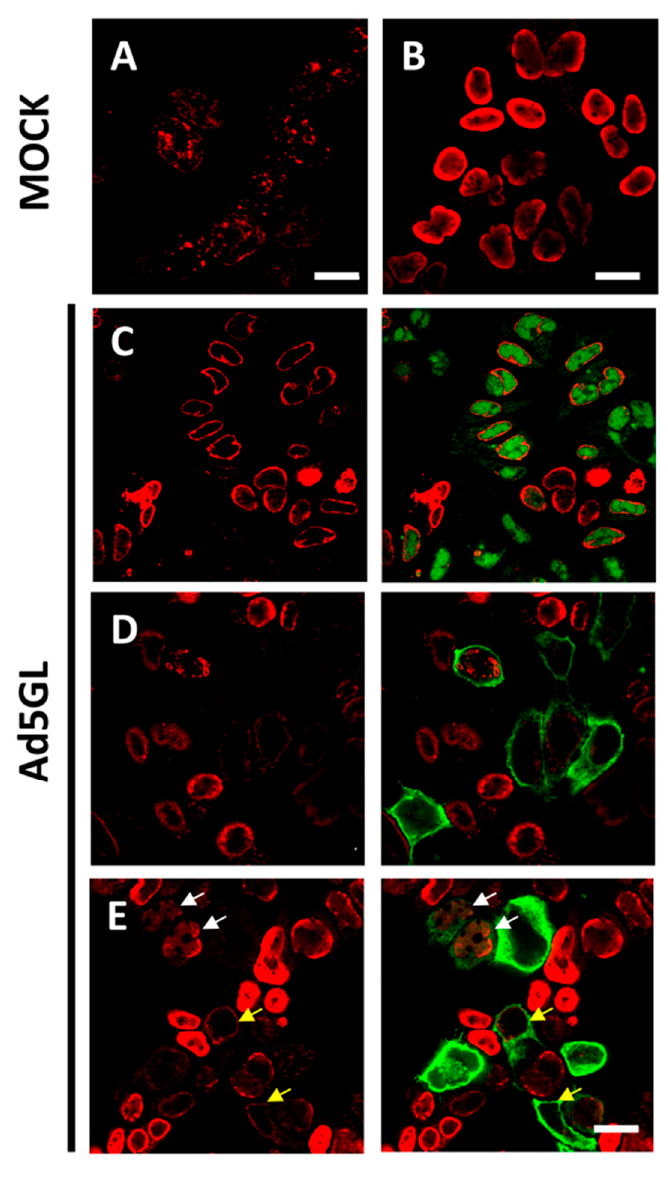
Figure 3. Labeling with short or long pulses of BrdU. Confocal planes showing uninfected HEK293 cells labeled 30 min before harvesting ( A ) or labeled for 24 h ( B ); and Ad5GL infected cells observed at 36 hpi with BrdU (25 µg/mL) added at ( C ) 8 hpi, ( D ) 12 hpi, or ( E ) 17 hpi. Red: BrdU. Green: GFP expressed by Ad5GL. Scale bar 10 µm in ( A ), 20 µm in ( B – E ). Yellow arrows indicate infected cells where the BrdU signal is similar to that in uninfected cells. White arrows indicate cells with both GFP and moderately strong BrdU signal.